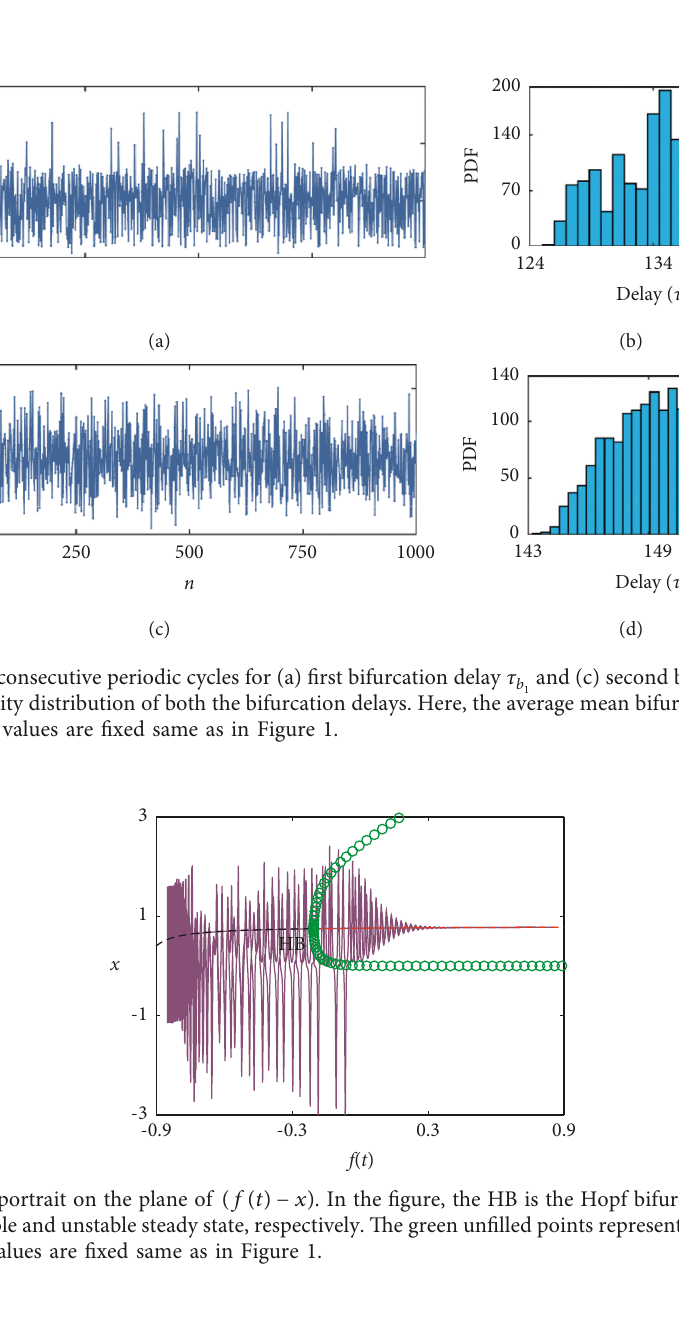
f t x . In the figure, the HB is the Hopf bifurcation point. The red and black ( ( ) − )